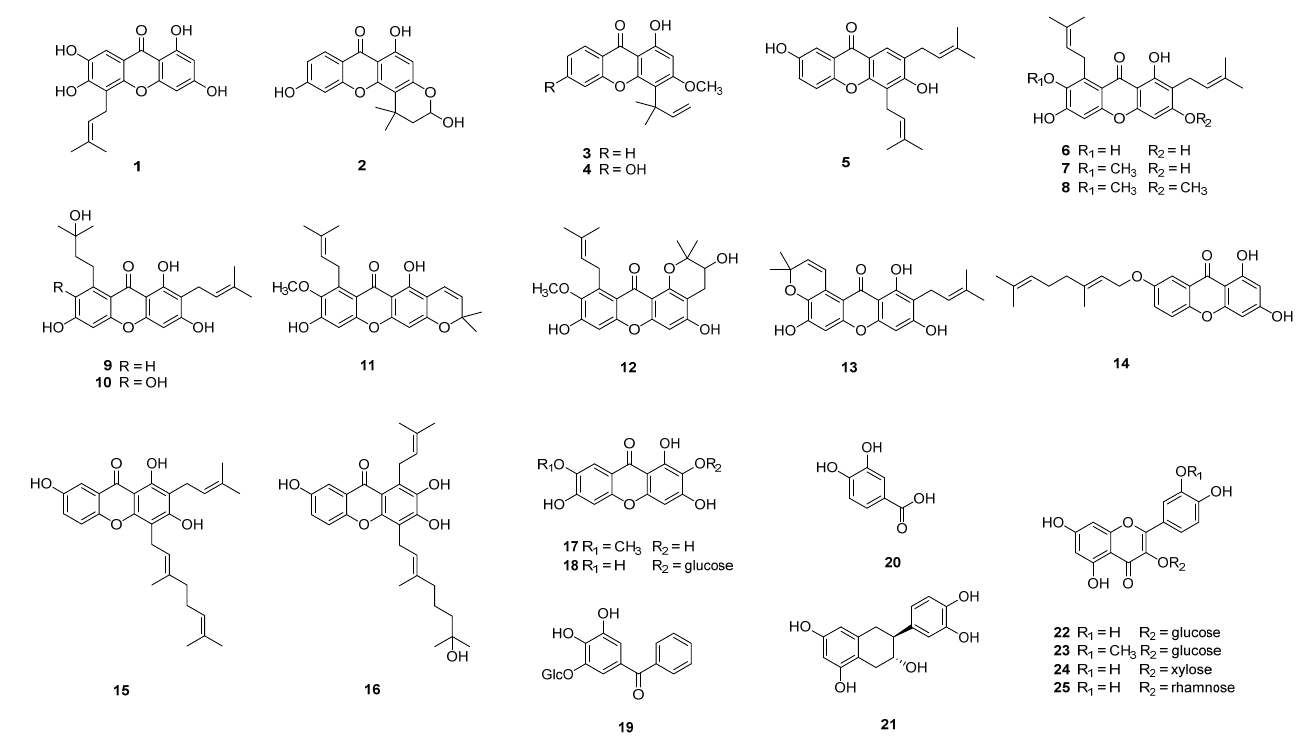
Figure 2. Chemical structures of compounds 1 – 25 from C. formosum ssp. pruniflorum.